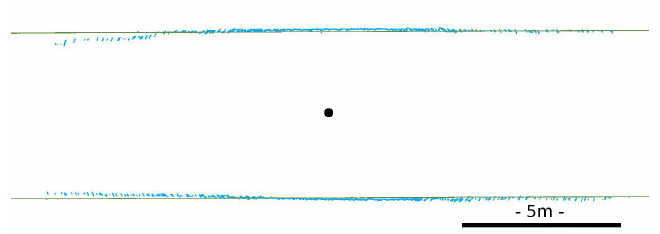
Figure 9. Horizontal cross section of the MSS (blue) and TLS (green) point clouds, where the sonar head position is marked by a black dot. The alignment of the models is done by the method described in Section 4.3.